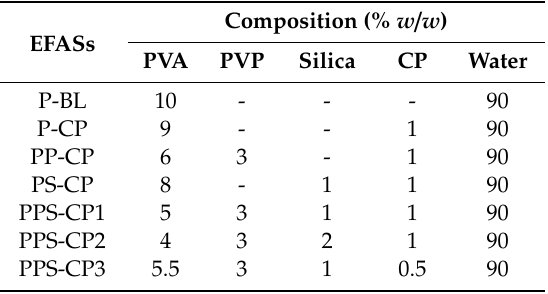
Table 1. Compositions of electrospinning feed aqueous solutions (EFASs). Composition (% w / w ) EFASs PVA PVP Silica CP